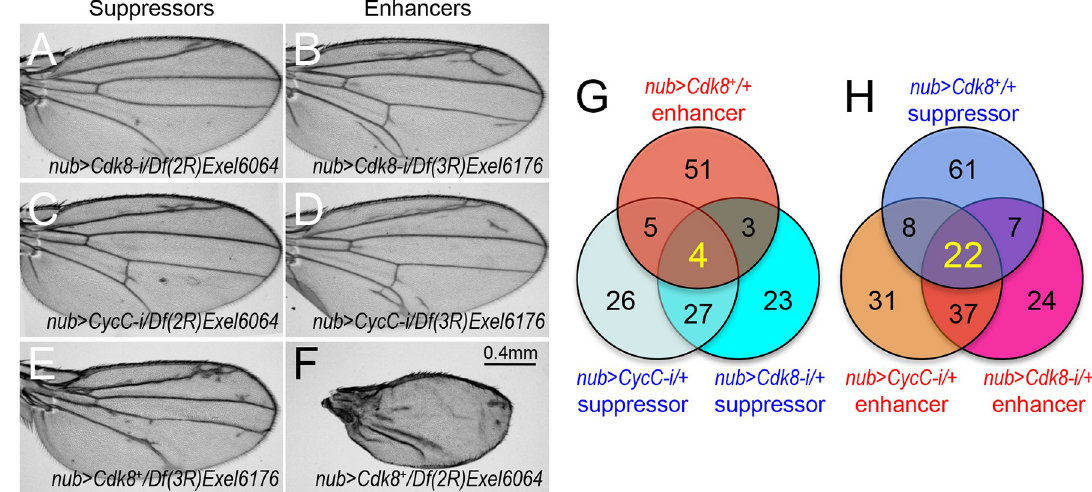
Fig 3. Identification of deficiency lines that can dominantly modify the vein phenotypes caused by varying CDK8. (A-F) Adult wings showing the examples of dominant modifiers. (A) nub-Gal4/Df(2R)Exel6064; UAS-Cdk8-RNAi (a suppressor of the CDK8-RNAi phenotype); (B) nub-Gal4/+; UAS-Cdk8-RNAi/Df(3R)Exel6176 , (an enhancer of the CDK8-RNAi phenotype); (C) nub-Gal4/Df(2R) Exel6064; UAS-CycC-RNAi/+ (a suppressor of the CycC-RNAi phenotype); (D) nub-Gal4/+; UAS-CycC-RNAi/Df(3R)Exel6176 (an enhancer of the CycC-RNAi phenotype); (E) nub-Gal4 > UAS-Cdk8 + /+; Df(3R)Exel6176 /+ (a suppressor of the CDK8-overexpression phenotype); and (F) nub-Gal4 > UAS-Cdk8 + /Df(2R)Exel6064 (an enhancer of the CDK8-overexpression phenotype). Scale bar in F: 0.4mm. (G and H) The Venn diagrams summarize the numbers of suppressors and enhancers of the CDK8-specific phenotypes.